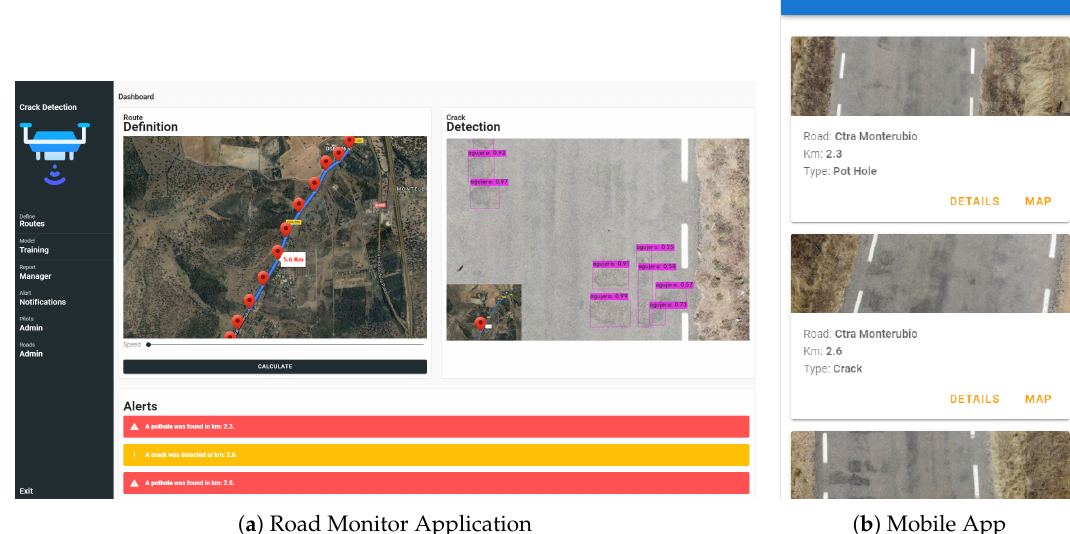
Figure 12. Application